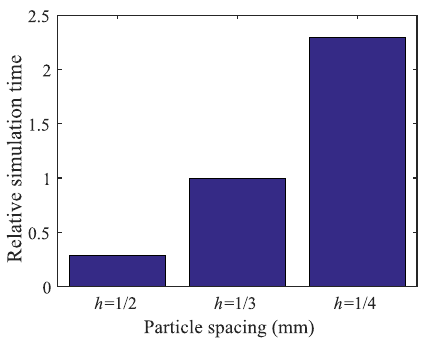
Figure 9. Effect of discretization on simulation time.